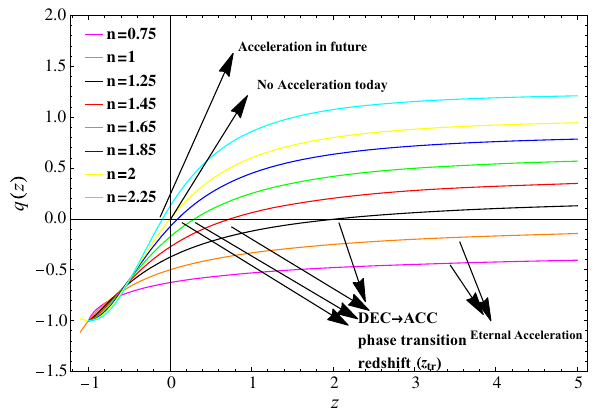
Fig. 1 The plots of the deceleration parameter vs. redshift z for dif- ferent n